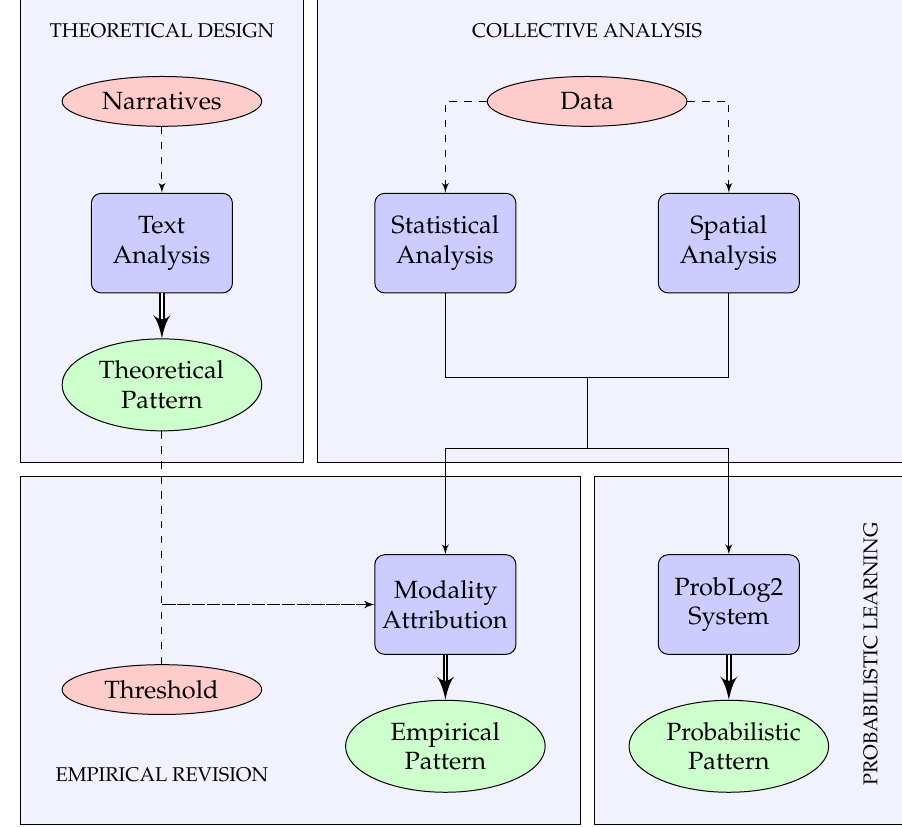
Figure 1. Empirical pattern extraction and probabilistic pattern learning